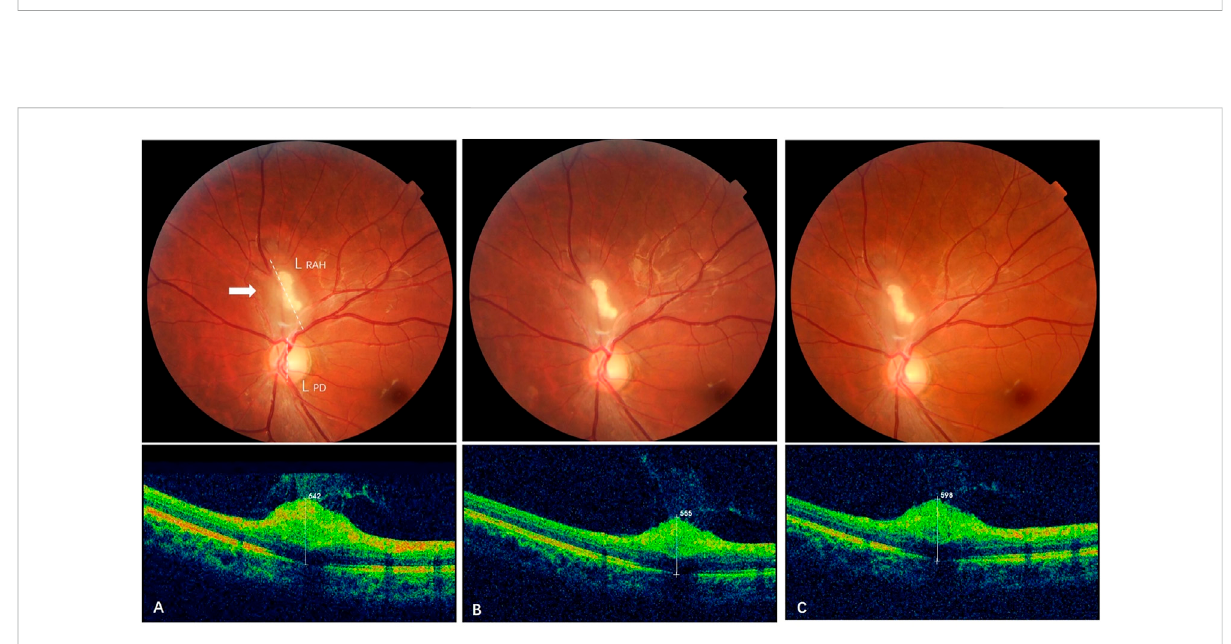
FIGURE 4 Effectofsirolimusontype3retinalastrocytichamartomaovertime. (A) Atbaseline,apartiallycalci fi edtype3RAHlesion(arrow)wasshownnext tothesuperioredgeoftheopticdisc withmaximalthickness (MT)642 μ mand alongest basediameter (LBD)1.51 DD(L RAH ,dashed line/L PD ,dashed line). (B) At 6-month follow-up (short-term), MT of the RAH decreased to 565 μ m on spectral-domain optical coherence tomography, and LBD generally remained the same as baseline, 1.50 DD. (C) At 33-month follow-up (long-term), reduction in RAH MT persisted with a mild reverse that the last MT was 598 μ m, while the LBD decreased to 1.45 DD for the last